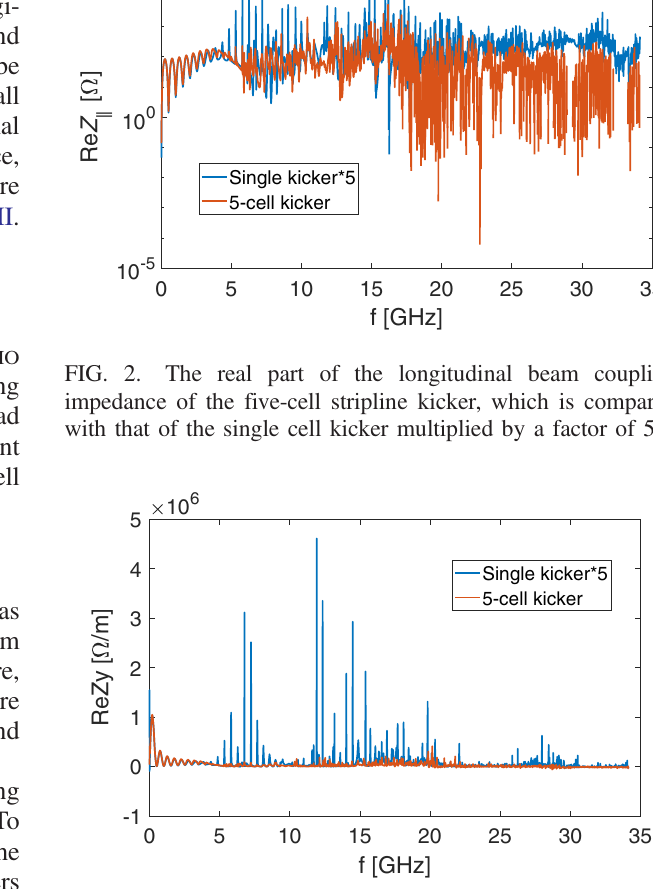
FIG. 3. The real part of the transverse beam coupling imped- ance of the five-cell stripline kicker, which is compared with that of the single cell kicker multiplied by a factor of